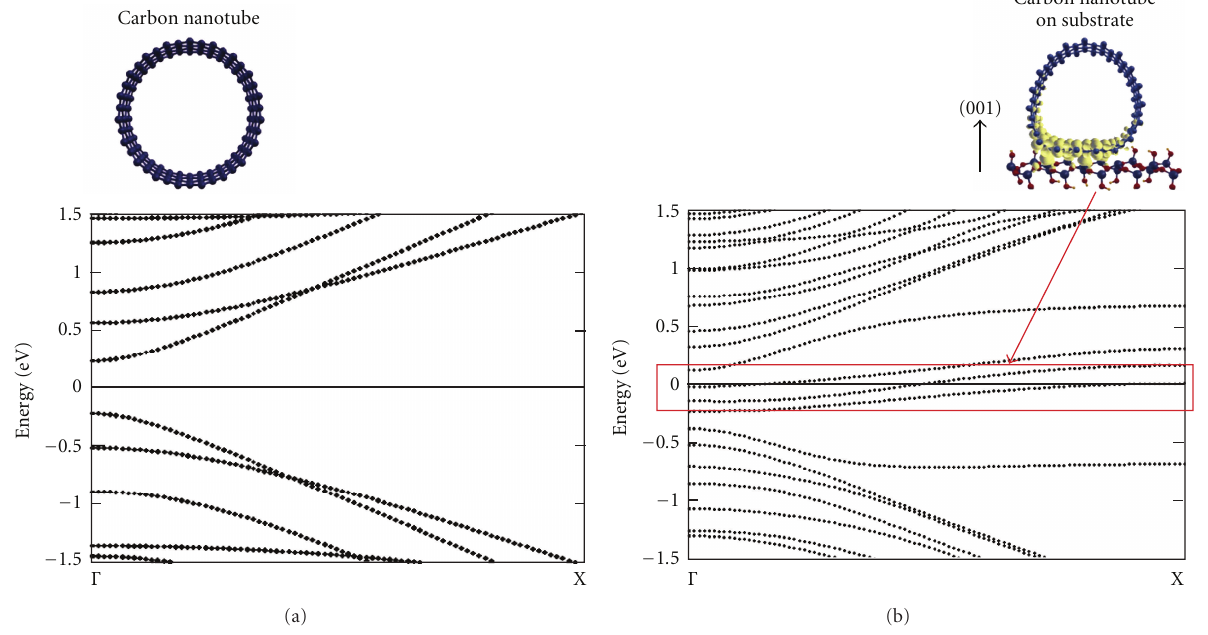
Figure 3: Band structure of the (19,0) carbon nanotube: (a) pristine and (b) interacting with a (001) surface of a quartz substrate with tube axis along (100). The Fermi level is set to zero. The insets show the respective atomic structures. The yellowish clouds in the inset (b) represent a plot of the electronic density for states within energies of up to 0.1 eV around the Fermi level (red rectangle in (b)). The bands responsible for the gap closure are localized spatially in the contact region along the flat surface of the nanotube (adapted from